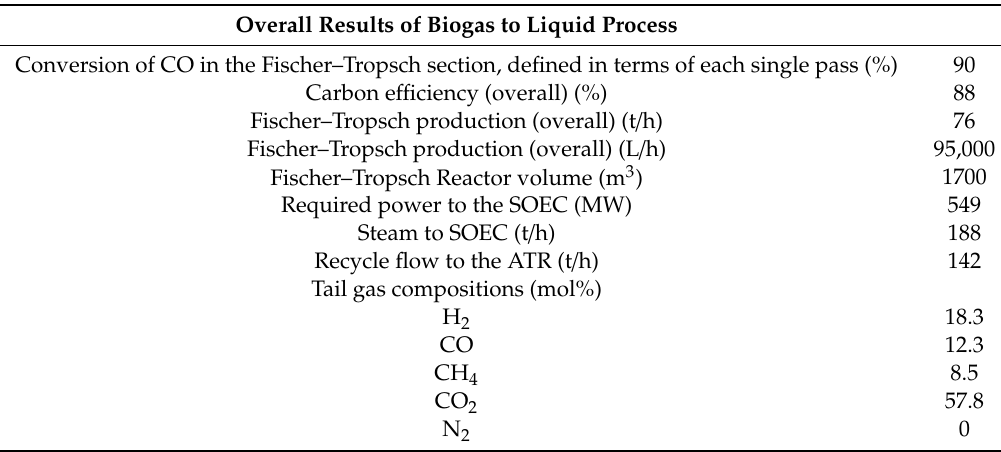
Table 4. Overall results of biogas to FT liquid process. Overall Results of Biogas to Liquid